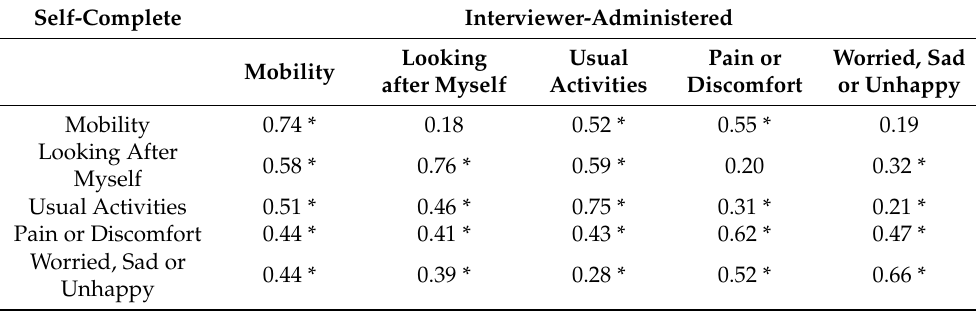
Table 6. Gamma correlations of self-complete and interviewer-administered dimension